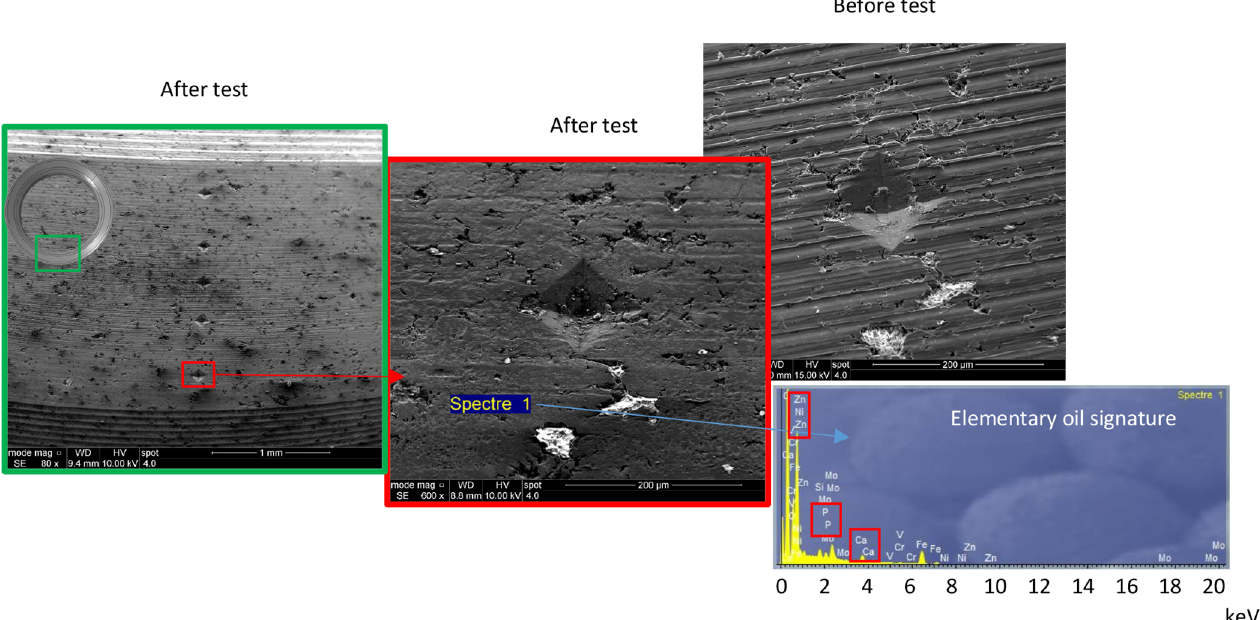
Fig. 29. Final surface of the seat after 4 hours of testing on the “ Cube ” in the case of an oil supply in the contact via the valve stem and with combustion gas circulation.